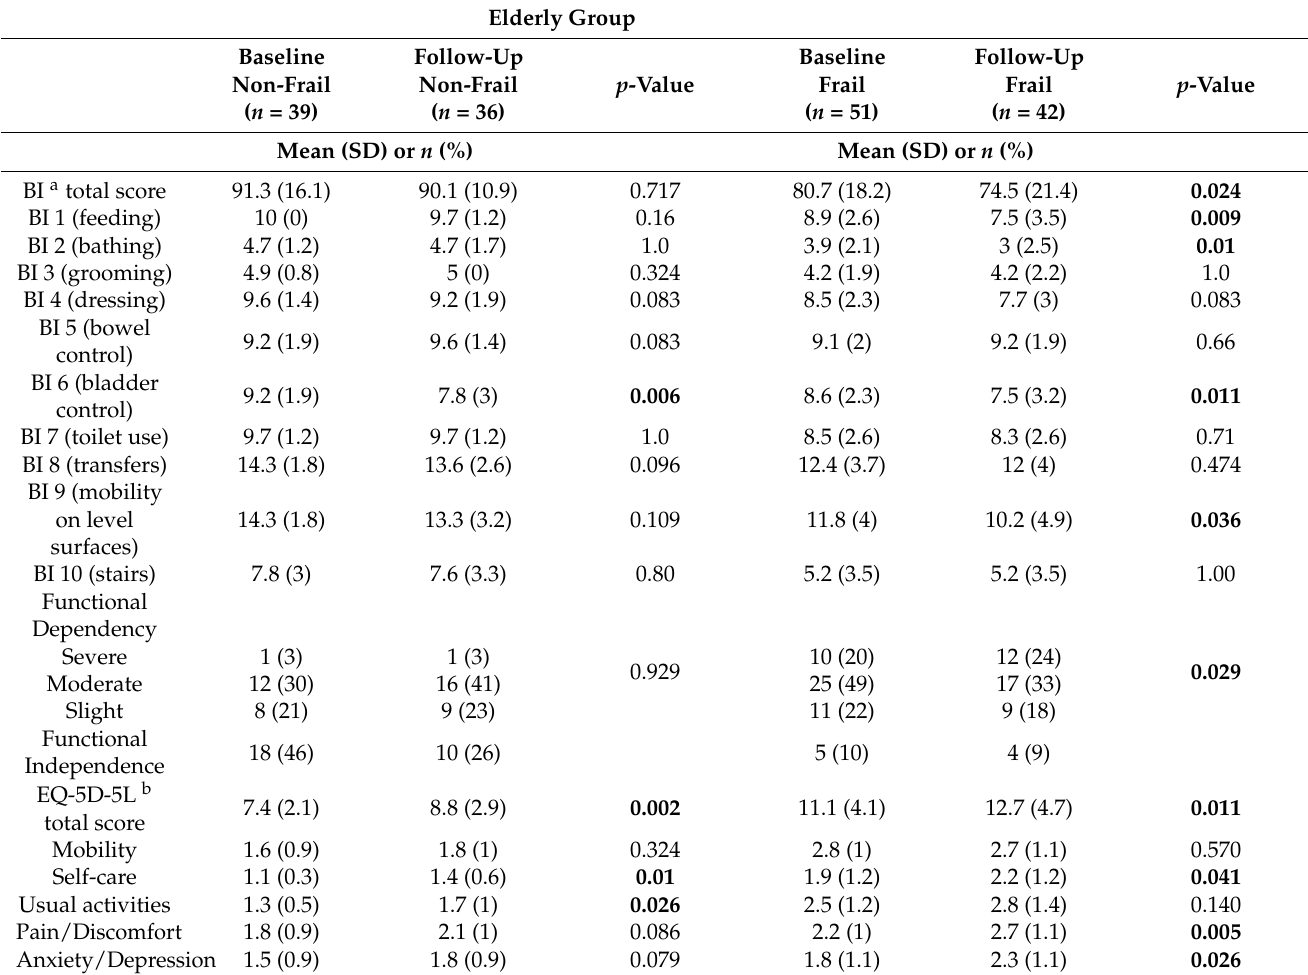
Table 3. Mean differences regarding functional status and QoL within elderly group at follow-up. Quantitative variables are expressed as mean (M) and standard deviation (SD), and qualitative variables as a